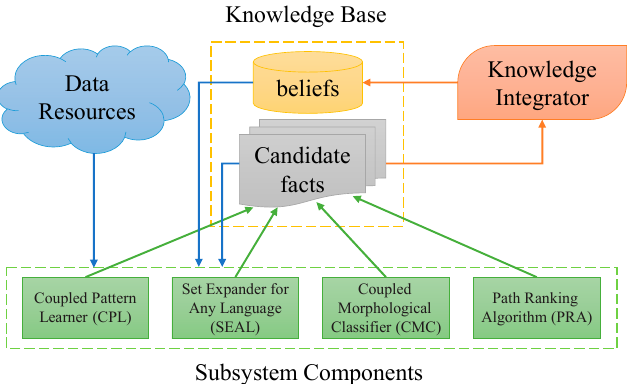
Figure 1. Never-Ending Language Learning model. Figure 1. Never‑Ending Language Learning